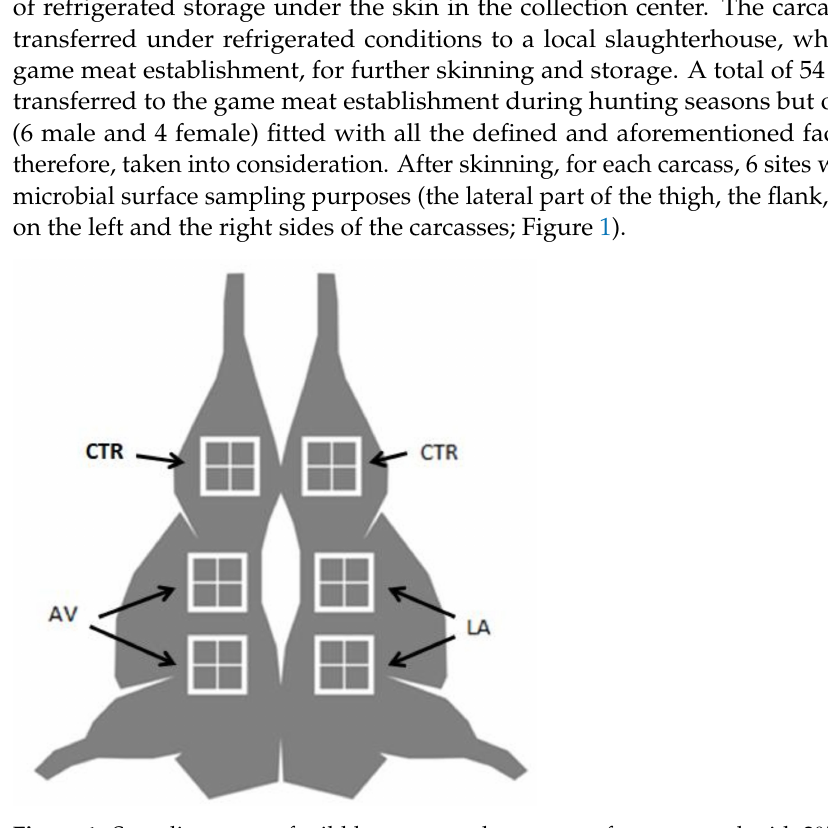
Figure 1. Sampling areas of wild boar external carcass surfaces sprayed with 2% lactic acid solu- tion (LA), aromatic vinegar (AV), or untreated